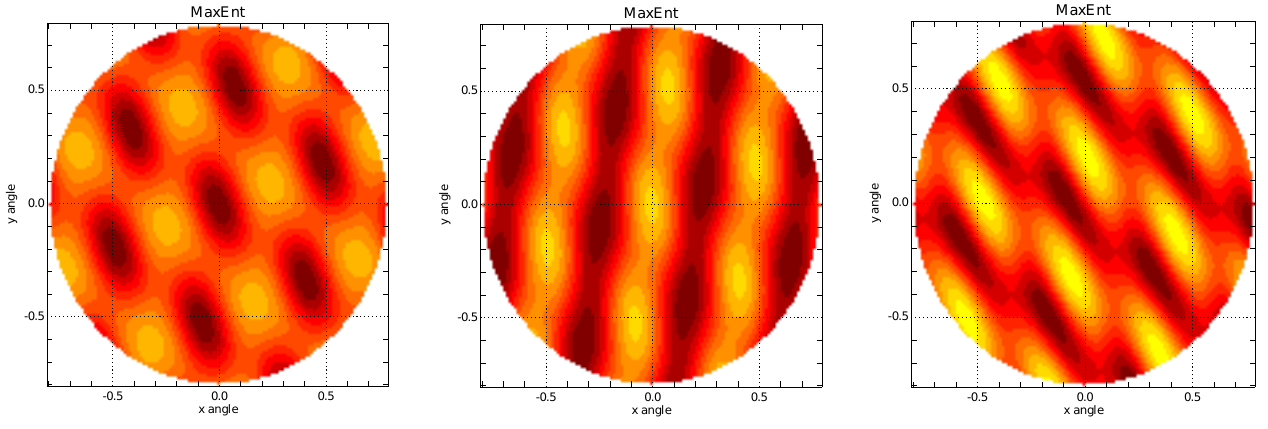
Fig. 3. Images obtained of the model brightnesses of Fig. 1 using the antenna configuration shown in Fig. 2 and a Maximum Entropy image inversion algorithm. Due to the lack of short baselines, the problems with aliasing are quite severe, and imaging is not possible. This configuration is still useful as a demonstration of the feasibility of obtaining useful signal and correlations out of the smaller antenna.